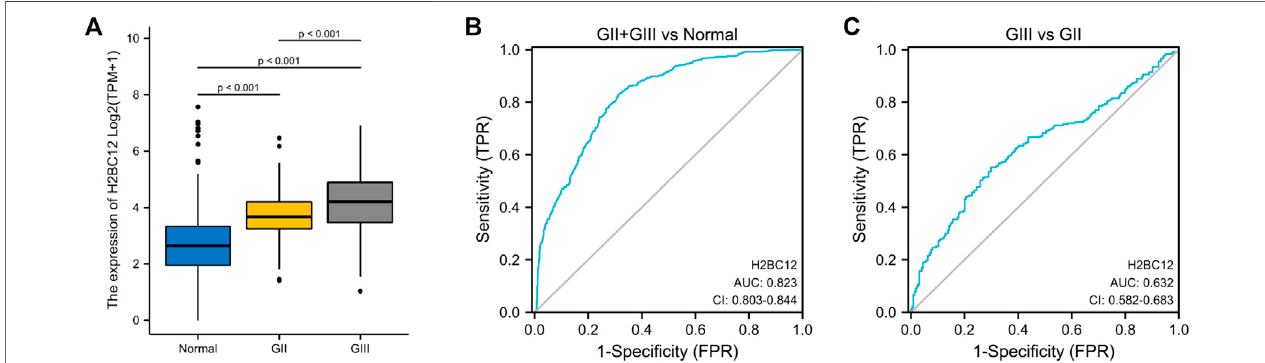
FIGURE 1 | The expression of H2BC12 mRNA in normal, GII, and GIII glioma tissue and its clinical value as a biomarker for distinguishing between GII and GIII gliomas. H2BC12 showed signi fi cantly higher expression in GII or GIII tissue versus normal tissue (A) , p < 0.001. The diagnostic ROC curve showed the accurate discriminative capability of H2BC12 in distinguishing between normal and GII + GIII (AUC = 0.823). (B) ROC analysis of H2BC12 in classi fi cation power for GII and GIII (AUC = 0.632).